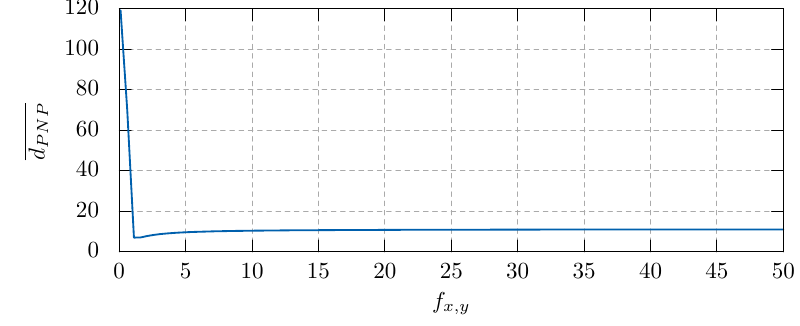
Figure 14. Focal length scale factor impact on d PNP metric.